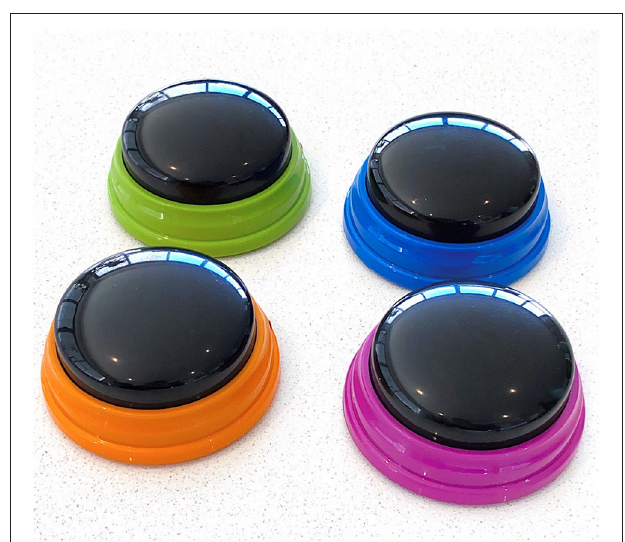
FIGURE 4 | Interactive hand buzzers replaced a “hand-clapping” task to enhance